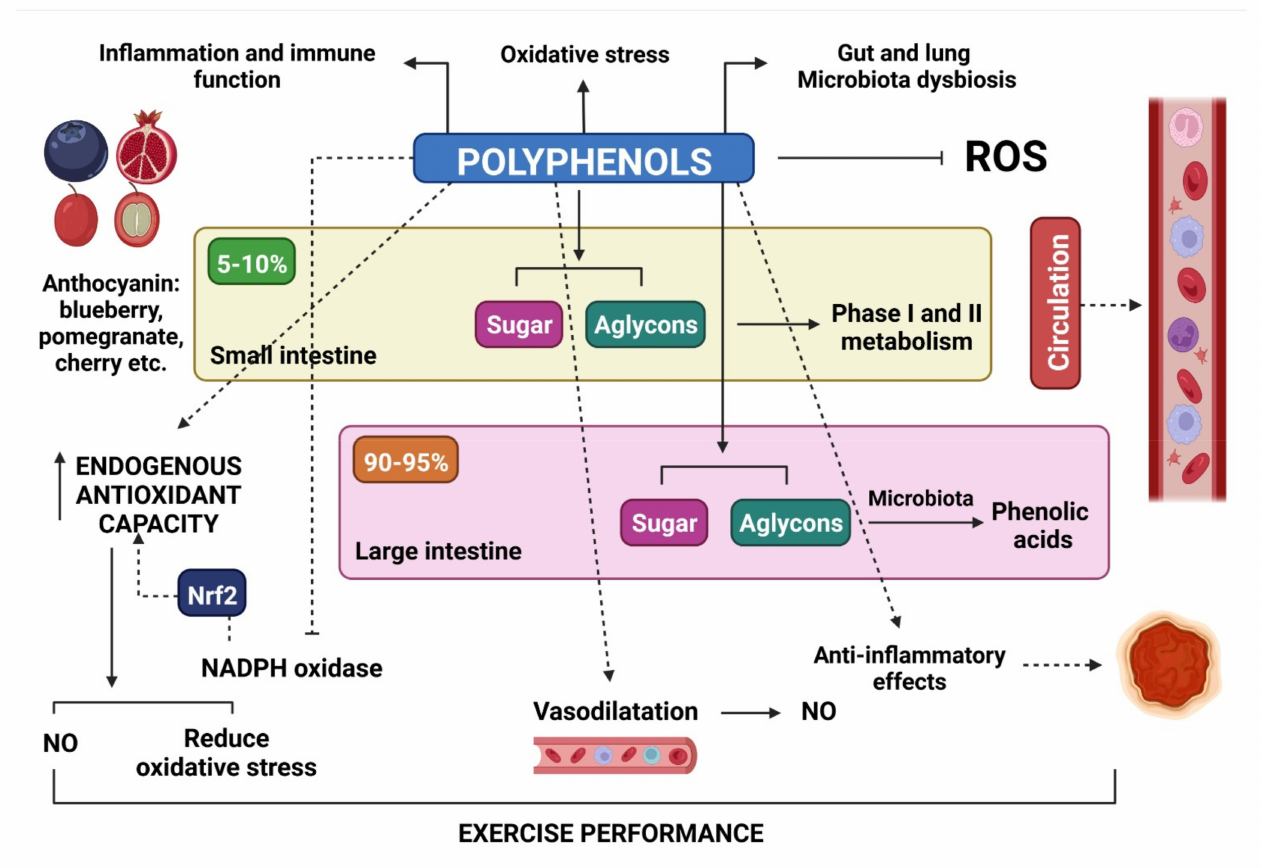
Figure 2. The impact of polyphenols on one’s health and the possibility of improving exercise